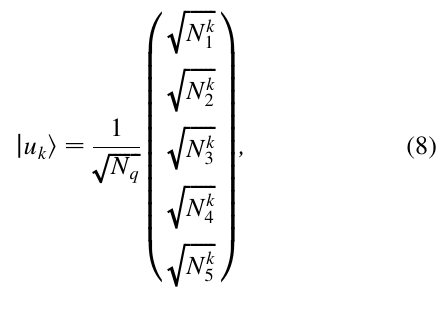
ffiffiffiffiffiffiffiffiffiffiffiffiffiffiffi